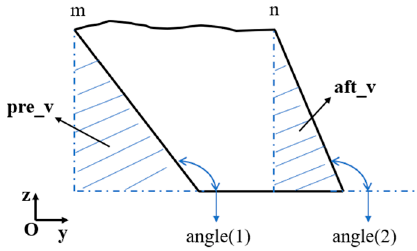
Figure 5. The front and rear angles cause changes in the volume calculation method.